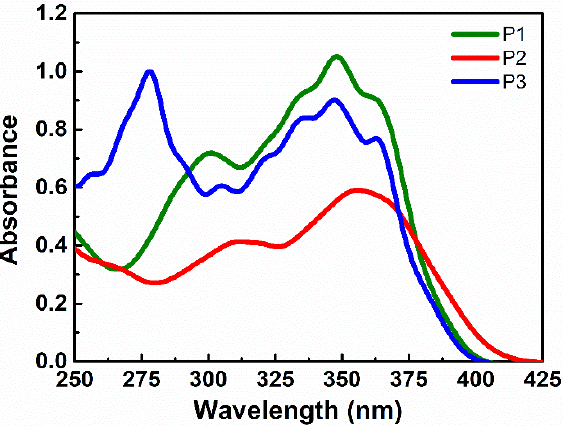
Figure 3. Absorption spectra of P1, P2, and P3 in tetrahydrofuran (THF) at room temperature.